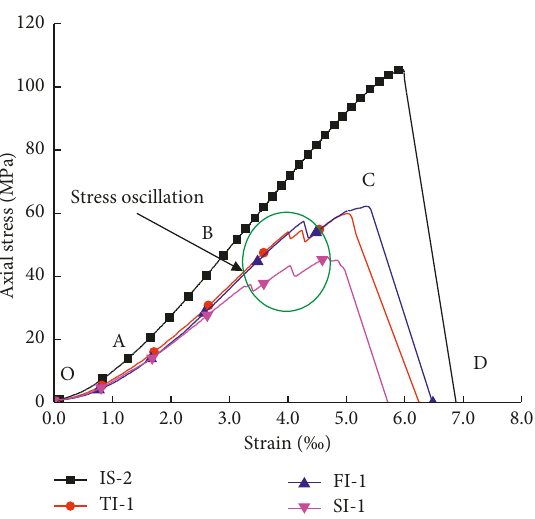
Figure 4: Axial stress-strain curves of four typical specimens under uniaxial compression. Table 2: Experimental results of specimens under axial